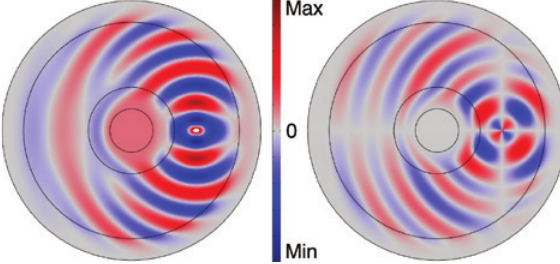
Figure 8: Numerical simulation (COMSOL MULTIPHYSICS) for a Figure 7: Numerical simulation (COMSOL MULTIPHYSICS) for a seismic flexural plane wave propagating from top to bottom in a plate of source placed in close proximity of a seismic cloak (inner radius r of thickness (15 m) small compared with the wavelength (800 m). 1 500 m and outer radius r of 1000 m) with effective elastic parameters (Left) Scattering by 9 regularly spaced clamped inclusions (of radius 2 of soil and geometry compatible with the design in Figure 6. 6 m) along a semicircle of radius 1020 m. (Right) Same with a seismic Medium surrounding the cloak is soft soil, source frequency is cloak (inner radius r of 500 m and outer radius r of 1000 m) consisting 1 2 0.1 Hz and polarization of the source is along the horizontal axis of 10 layers of isotropic homogeneous layers with a negative Young’s (compressional wave). The horizontal (dilatational) displacement modulus and a negative density deduced from the same space folding (left) is not completely damped inside the inner disc (soil), but the transform as in [65, 66]. One notes the significantly reduced scattering vertical (shear) displacement (right) indeed vanishes. Such a cloak in the right panel, as well as the exalted field on the cloak’s outer therefore offers protection against shearing (most deleterious wave boundary (cf. white spots where field magnitude is outside color scale, polarization) and any large structure (i.e. an amphitheater or a it is typically 3 times larger than stadium) placed in the center region would be safe.